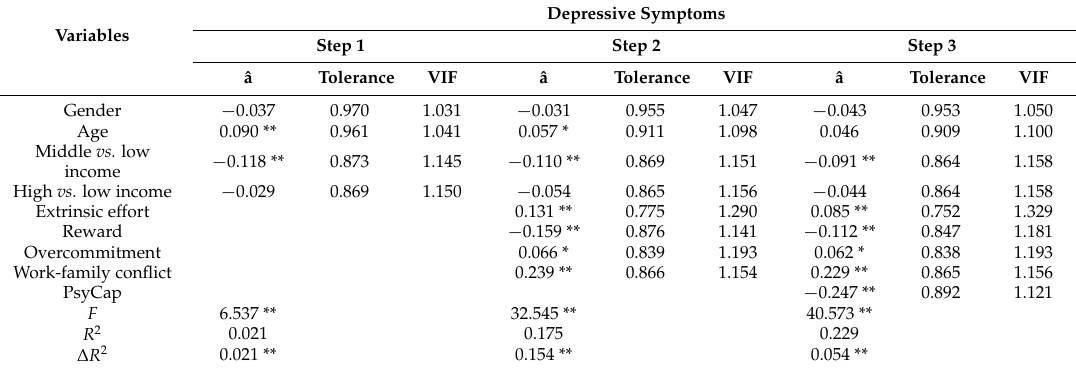
Table 3. Hierarchical linear regression analysis results with depressive symptoms as criterion variable ( n = 1239).